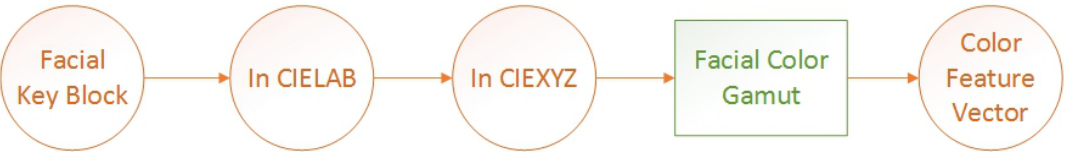
Figure 8. Facial color gamut.